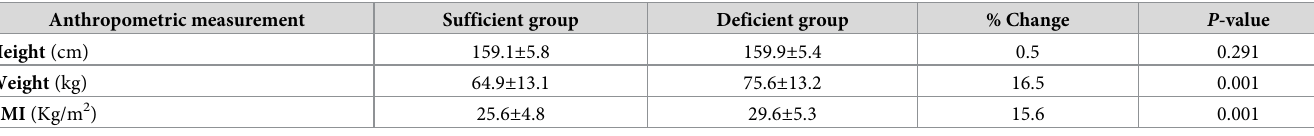
Table 2. Anthropometric measurements of participants in case and control